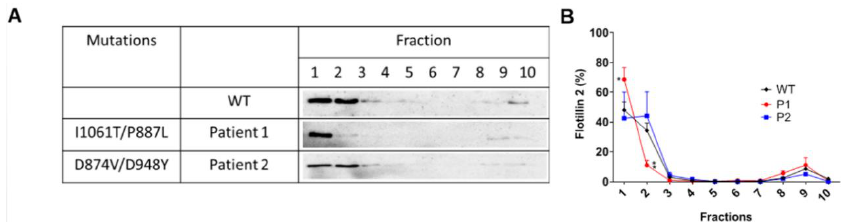
Figure 5. Cells were lysed in Lubrol and separated on a sucrose density gradient. Immunoblotting was subsequently performed to determine the distribution of flotillin-2. Representative immunoblots ( A ) and graphs based on quantification of three independent repetitions ( B ). WT represents at least three repetitions from three WT fibroblasts. SEM, Student’s t -test * p ≤ 0.05.